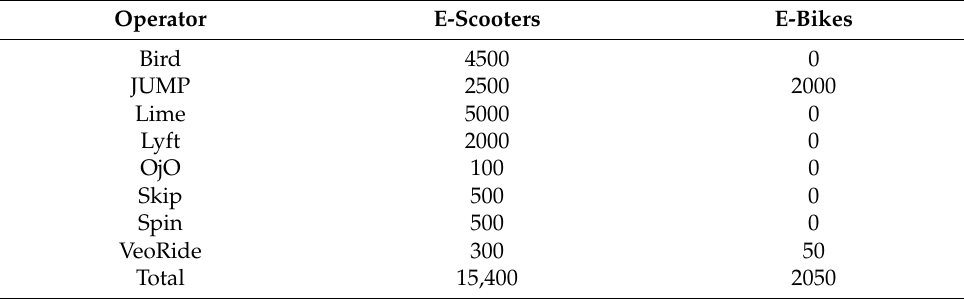
Table 1. List of operators licensed to serve in Austin, TX.